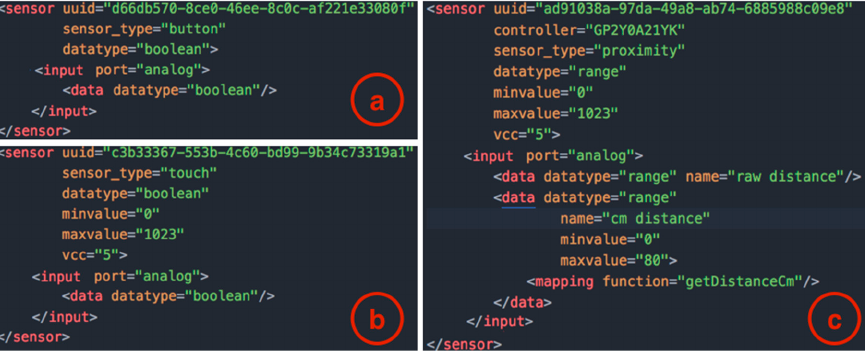
Figure 5. Excerpts from the XML file with the templates for the definition of sensors: ( a ) a button; ( b ) a touch sensor and; ( c ) a proximity sensor.